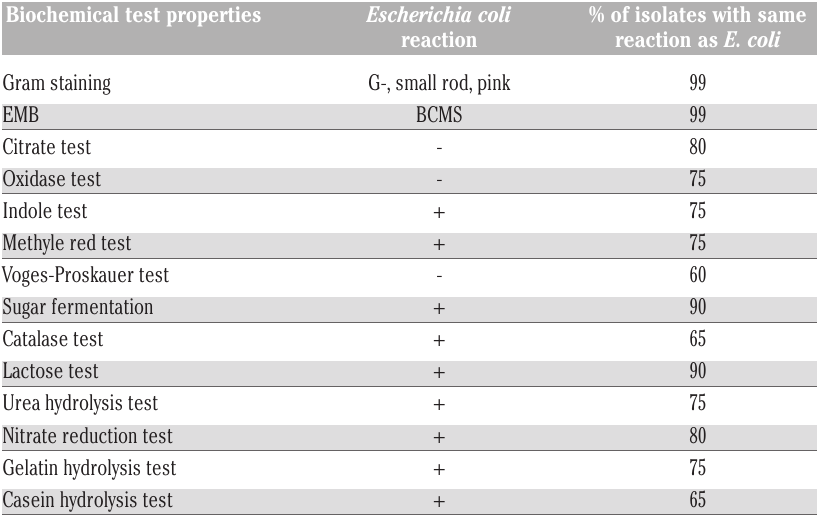
Table 4. Biochemical tests used for identification of Escherichia coli .